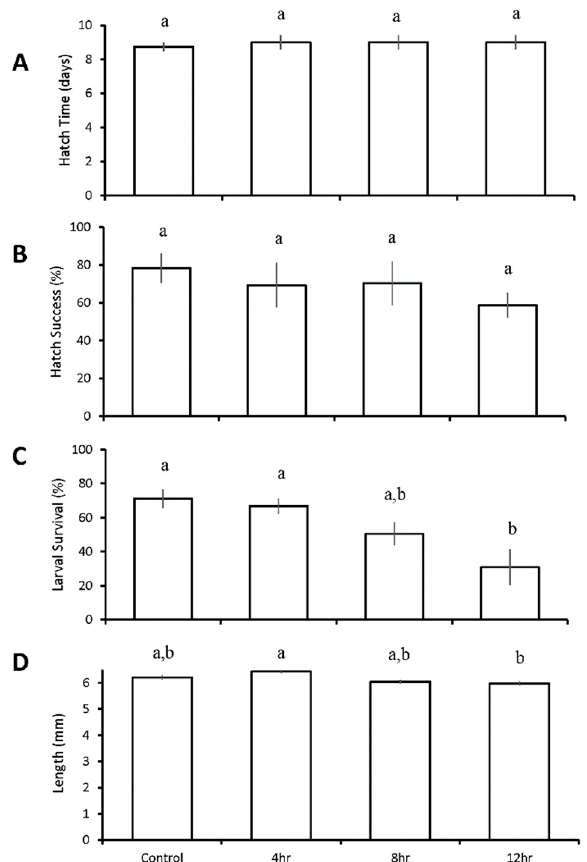
Figure 6. Hatch time ( A ), hatch success ( B ), survival ( C ), and length ( D ) of Menidia beryllina II larvae in the four treatment diurnal duration acidification and hypoxia experiment (Table 7 and Tables S21–S24) Bars represent the mean (n = 4) for each treatment. Error bars represent standard error of the mean (n = 4). Letters on bars represent significant di ff erences among groups as determined by Tukey Honest Significance Di ff erence tests.